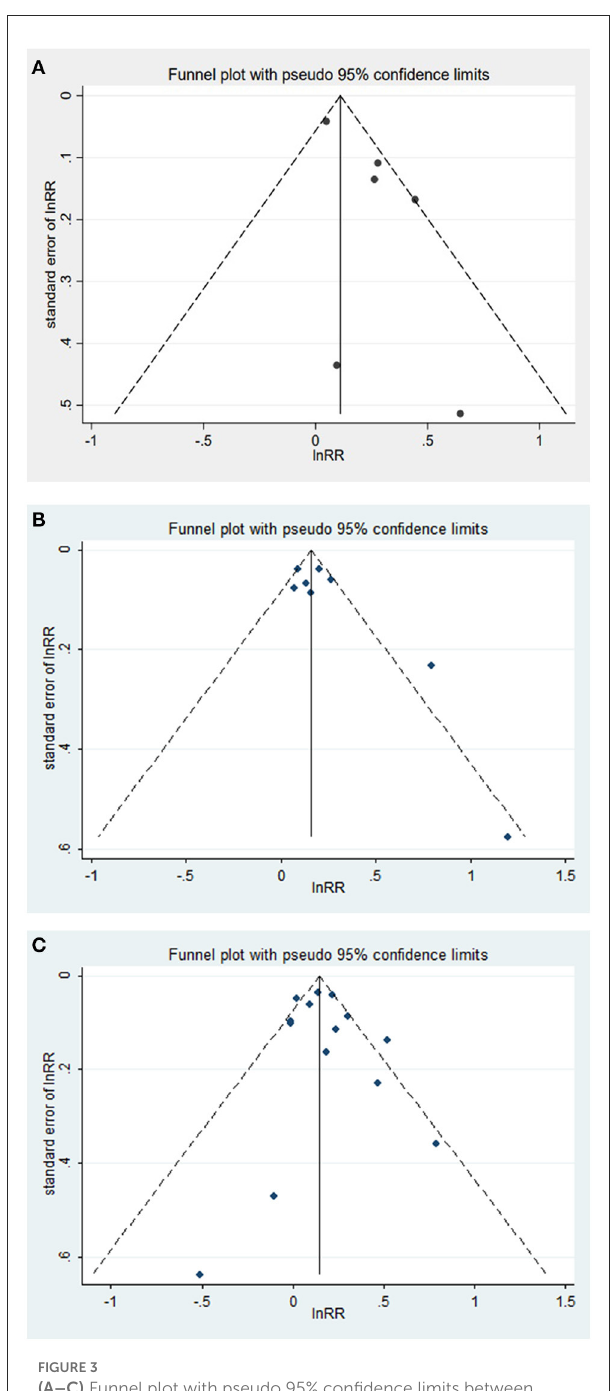
FIGURE3 (A–C) Funnel plot with pseudo 95% confidence limits between tooth loss and dementia, cognitive decline.